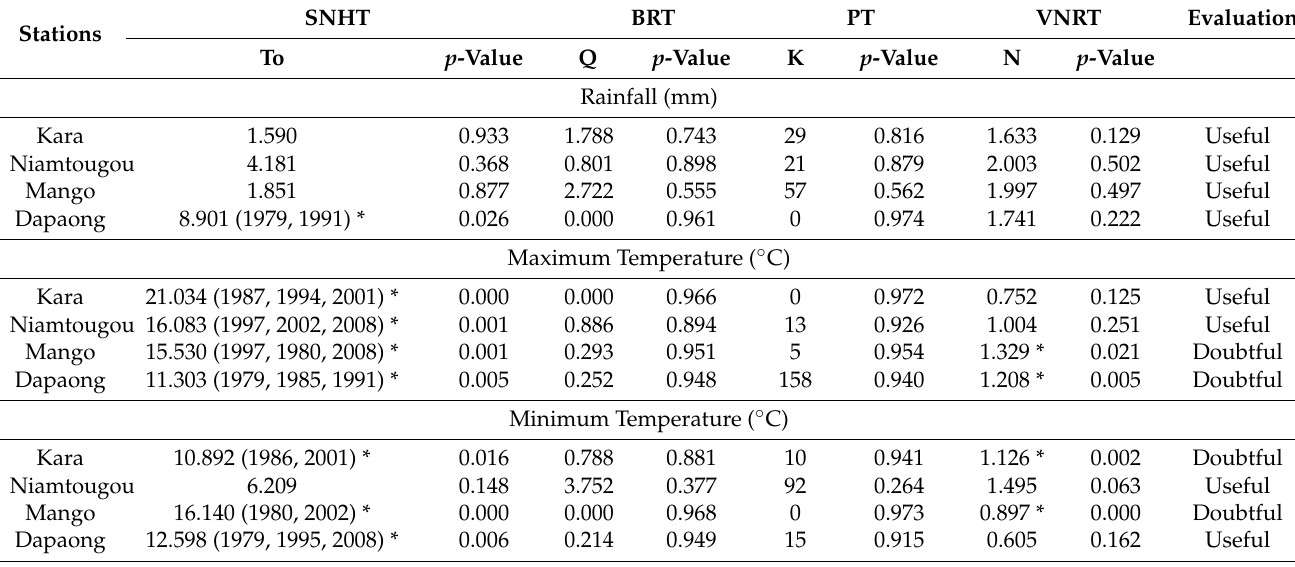
* Indicates the inhomogeneous stations at 5% significance level; the values in the parentheses represent the break point years (Von Neumann’s Ratio Test (VNRT) gives no information about the break point); To, Q, K, and N stand for the resulting coefficients of the different